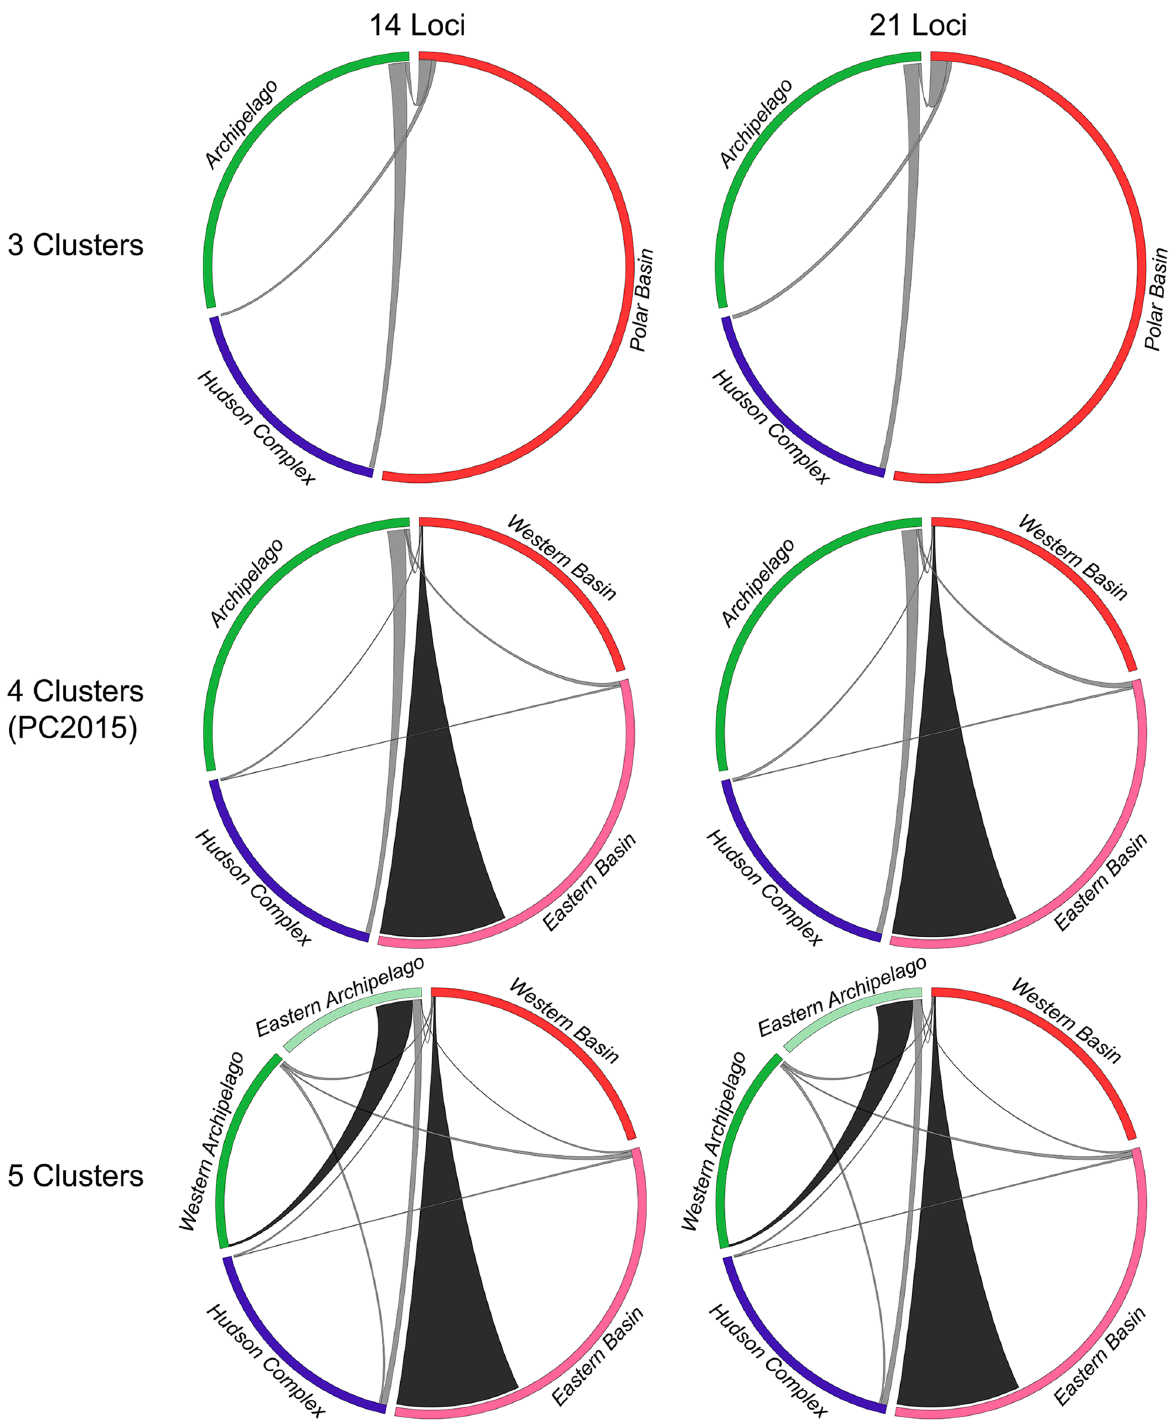
Fig 6. C IRCOS plots of gene flow using 14 or 21 loci among: three clusters corresponding to our S TRUCTURE results for K = 4 (excl. Norwegian Bay samples), four clusters identified in Peacock et al ., 2015 [20] (excl. Norwegian Bay samples), and five clusters corresponding to our S TRUCTURE results for K = 6 (excl. Norwegian Bay samples). Segment colours are as in Fig 4 and are sized proportionally to the population size estimates in Table D of S1 File, though polar bear population sizes are estimated with very broad confidence intervals, particularly in the Polar Basin, where reliable estimates are not available for most MUs. The width of each ribbon where it meets a segment on the circumference indicates the proportion of migrants into (but not out of) each region. Black ribbons are significantly directional based on non-overlapping 95% CIs of immigration rates; grey ribbons are not significantly directional.